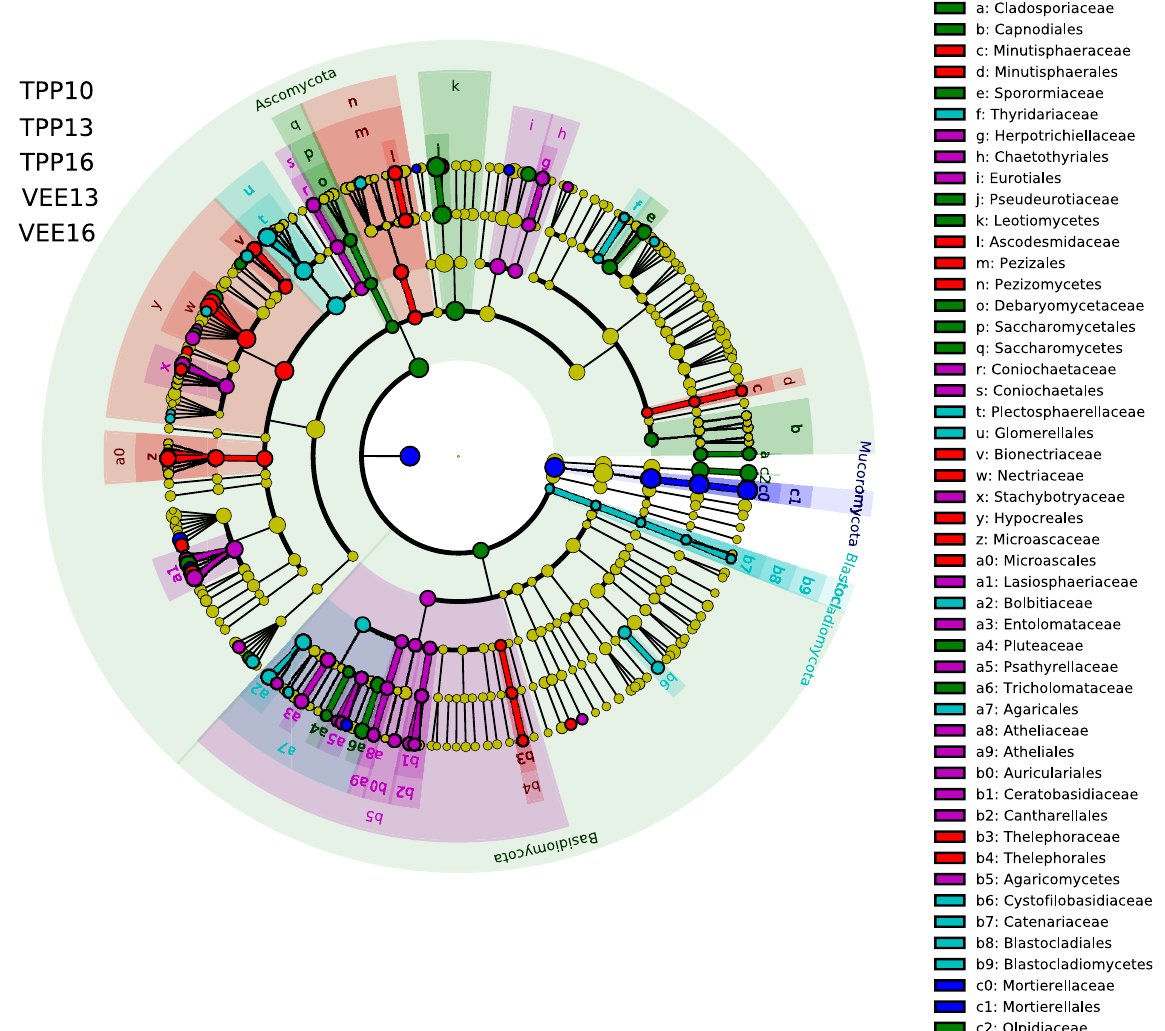
Figure 5. Analysis of the differences in the composition of the fungal community between the two planting patterns (LDA scores greater than